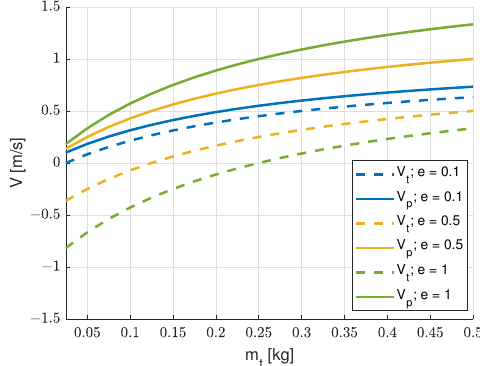
Figure 3. Influence of moving mass on end velocities.